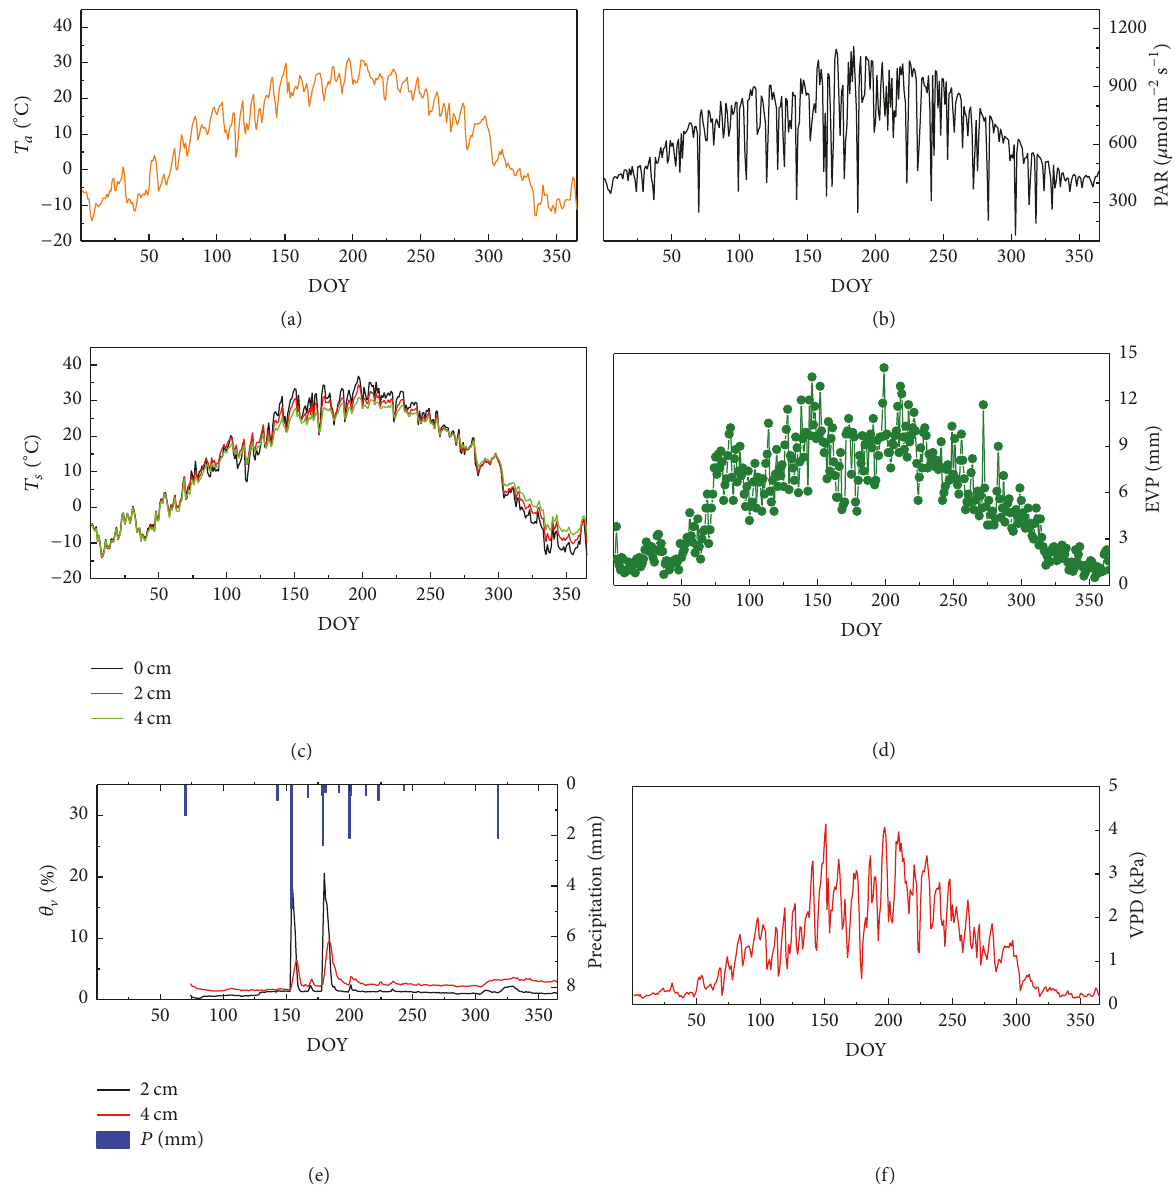
Figure 2: Seasonal variation of daily average air temperature ( 𝑇 𝑎 ), daily average photosynthetic active radiation (PAR), daily average soil temperature ( 𝑇 𝑠 ), daily average potential evapotranspiration (EVP), daily average vapor pressure deficit (VPD), daily average soil volumetric water content ( 𝜃 V ), and daily total precipitation ( 𝑃